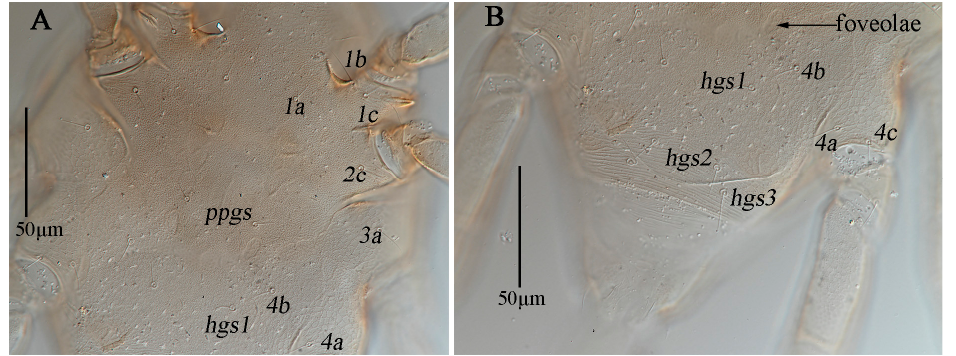
Figure 18. Brevicaudus trapezoides sp. nov . (male). ( A , B )—Ventral idiosoma (photo). Scale bar = 50 µm.